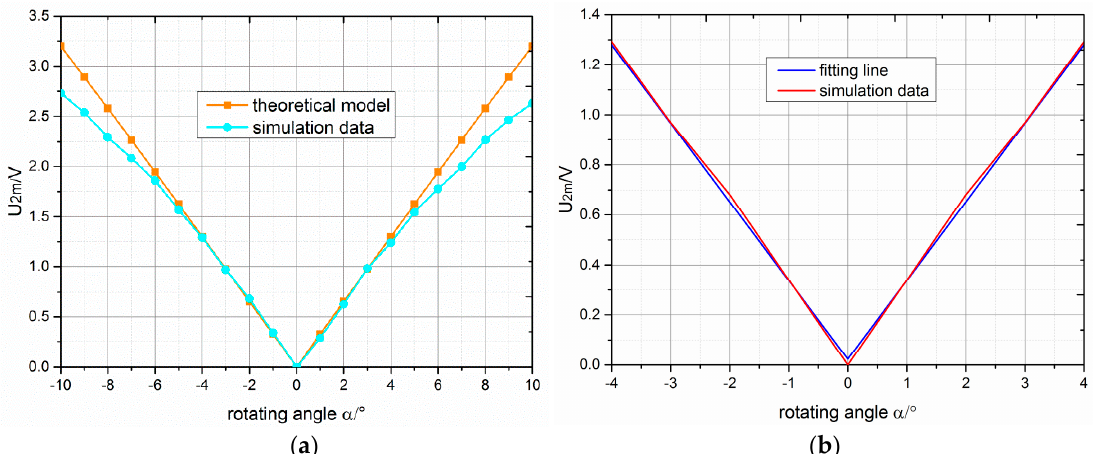
Figure 8. ( a ) Variation of output voltage amplitude with angle of rotation in the theoretical model and simulation; ( b ) linear fitting of simulation data within ±4°.